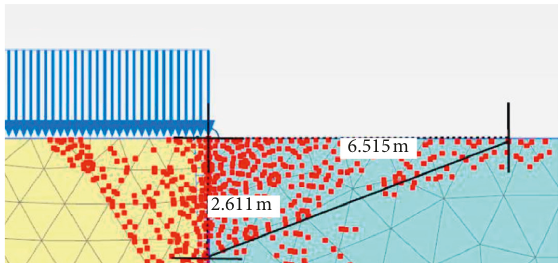
Figure 14: Distribution of failure points inside the foundation pit at φ � 30 ° .